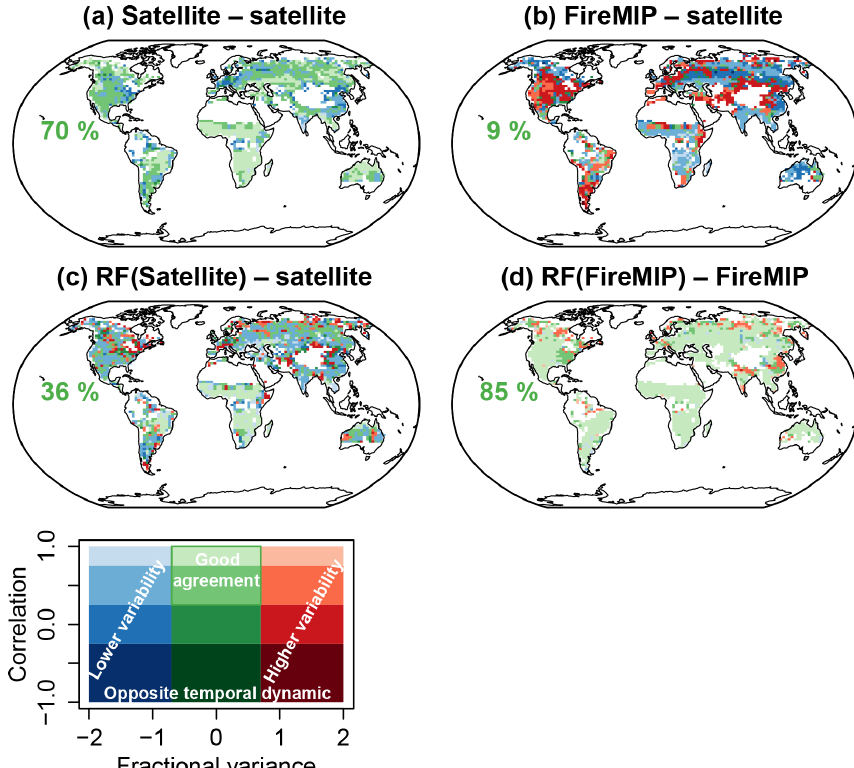
Figure 2. Comparison of temporal burned area dynamics from satellite data sets, fire-enabled DGVMs, and random forest. The maps show the median Spearman rank correlation coefficient and median fractional variance of the monthly burned area from 2005 to 2011 between (a) satellite data sets and the other satellite data sets (Fig. S3), (b) FireMIP model simulations and all satellite data sets (Fig. S4), (c) predicted burned area from RF and all satellite data sets (“full” set of predictor variables, Fig. S5), and (d) predicted burned area from RF trained against FireMIP models and the corresponding simulated burned area from each FireMIP model (Fig. S7). Green percentage numbers indicate the land area with “good” agreement (correlation ≥ 0 . 25 and − 0 . 7 ≤ FV ≤ 0 . 7). Regions with missing data (white) either had no vegetation cover (e.g. deserts, ice sheets), had no burned area (e.g. parts of the Amazon and tundra), or were not covered by the vegetation carbon map used (i.e. regions in southern Australia and New